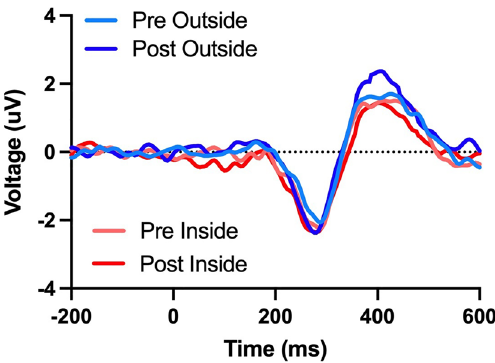
Figure 2. Grand average ERP difference waveforms for the visual oddball pre-test and post-test for indoor and outdoor walks. Note the P300 ERP component increased in the post-test following outdoor walks.